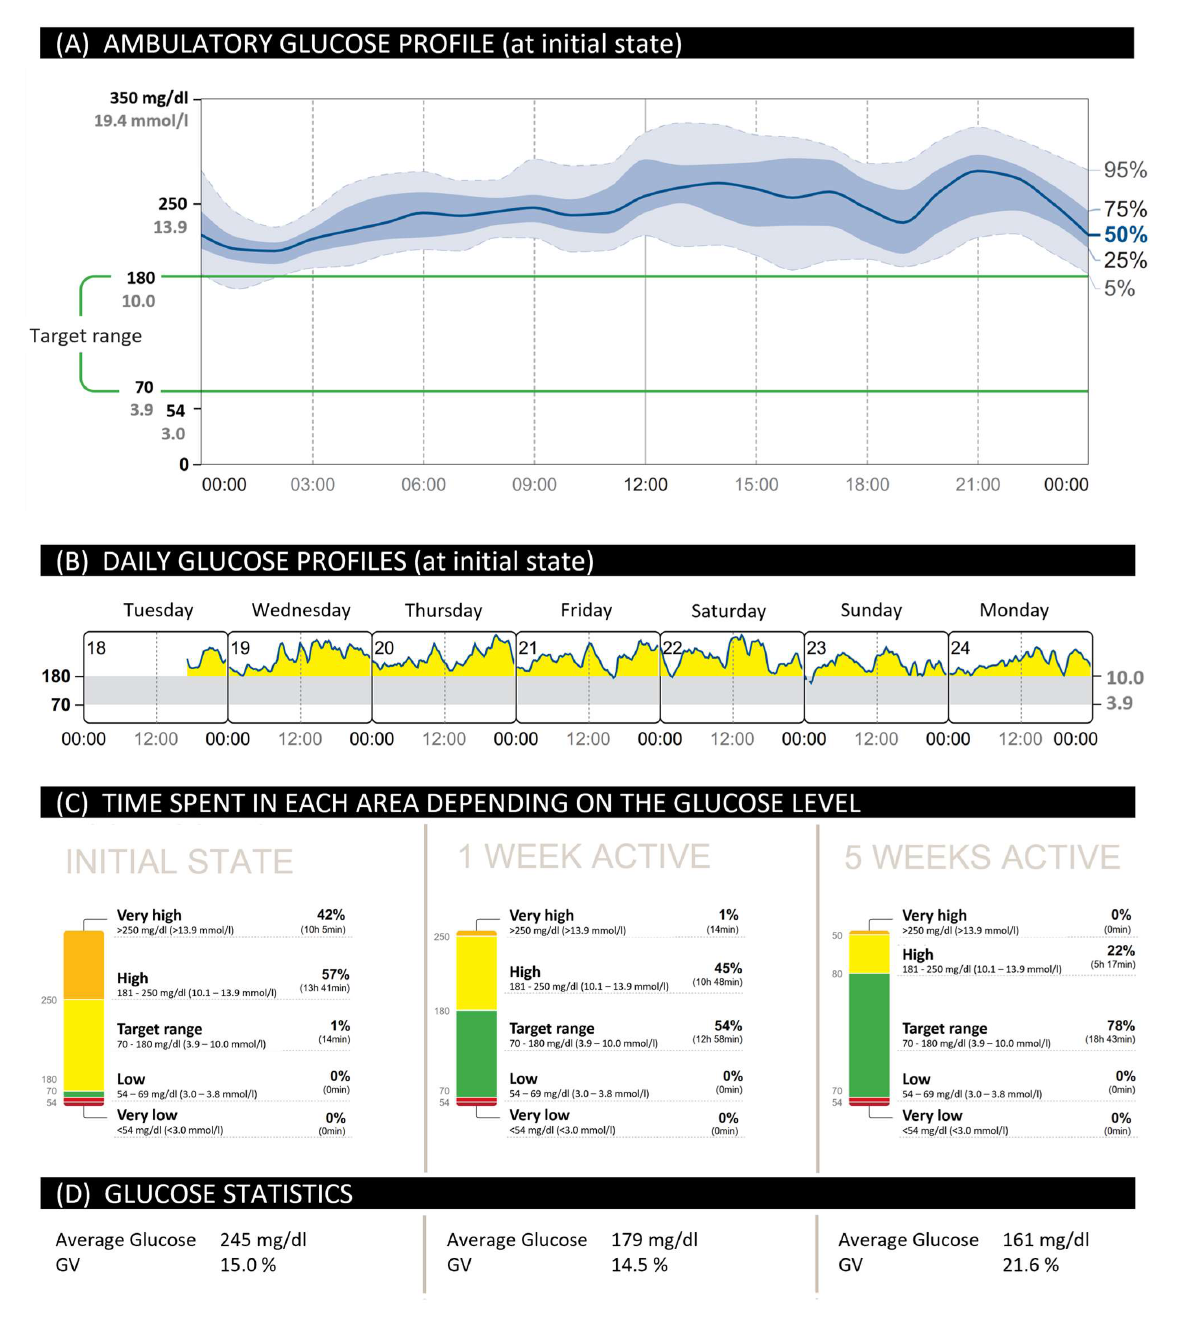
Figure 1. CGM data report of a 54-year-old German man with type 2 diabetes (T2D)—a real-world case study from February 2020 (adapted to Brinkmann et al. [33]). Ambulatory glucose profile ( A ) and daily glucose profiles ( B ) before regular physical activity. Data on time in range (TIR) ( C ) and glucose statistics ( D ) are indicated for three different time points—at the patient’s initial state (left), as well as after one (middle) and five weeks of physical activity (right). GV: glycemic variability.